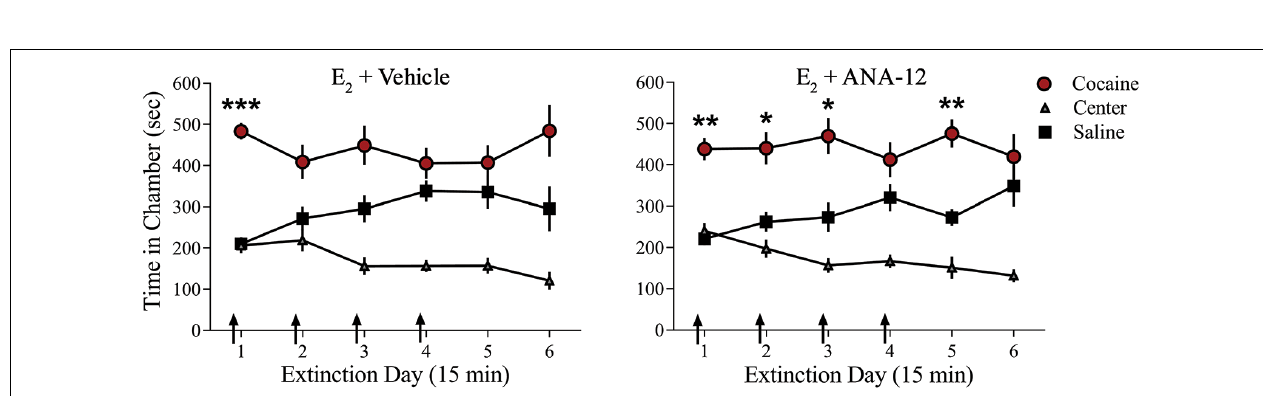
FIGURE 4 | Injections of selective TrkB receptor antagonist disrupted E 2 -induced facilitation of extinction of a cocaine CPP. Systemic injections (arrows) of E 2 + ANA-12 ( n = 9) but not E 2 + vehicle ( n = 10) before the first four CPP trials impaired extinction. ∗∗∗ p < 0.001, ∗∗ p < 0.01, and ∗ p < 0.05. Error bars indicate SEM.